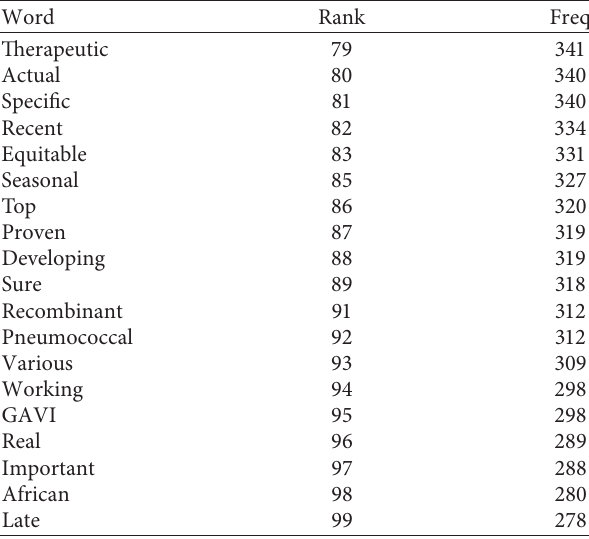
Table 3: Neutral collocation of the word